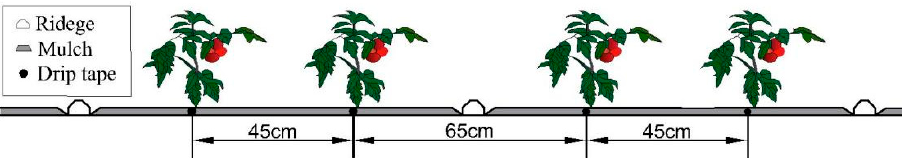
Figure 7. Diagram of the greenhouse tomato growing pa tt ern.